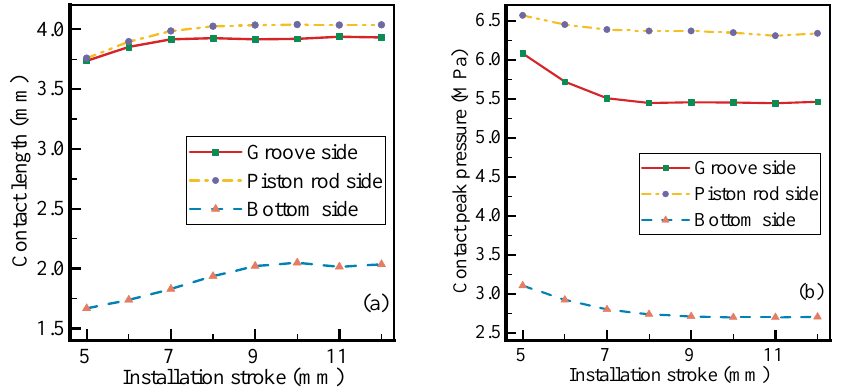
Figure 8. Comparison of installation stroke. The contact length in ( a ) and contact peak pressure in ( b ) under eight different installation strokes are compared at three positions, including groove side, piston rod side and bottom